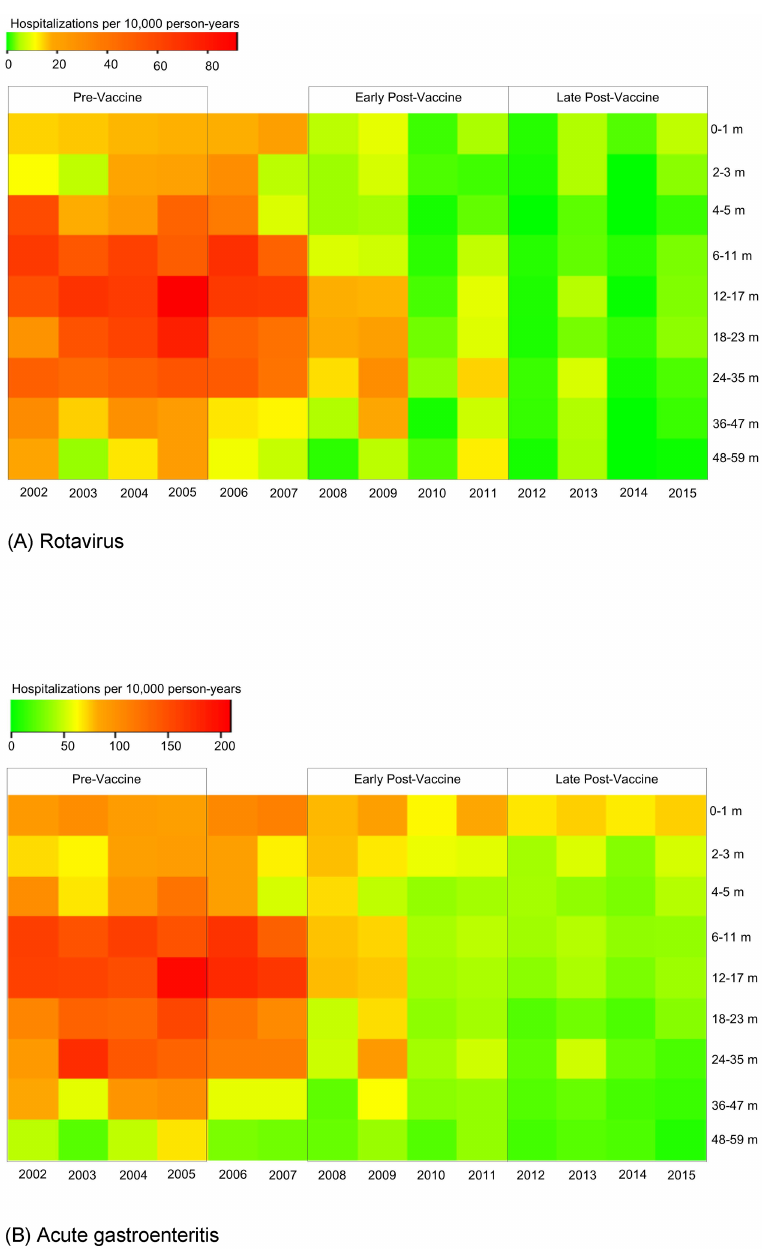
Fig 1. Hospitalization rates stratified by age among children < 60 months. (A) Rotavirus- and (B) acute gastroenteritis- coded hospitalizations during rotavirus seasons (Jan-Jun),